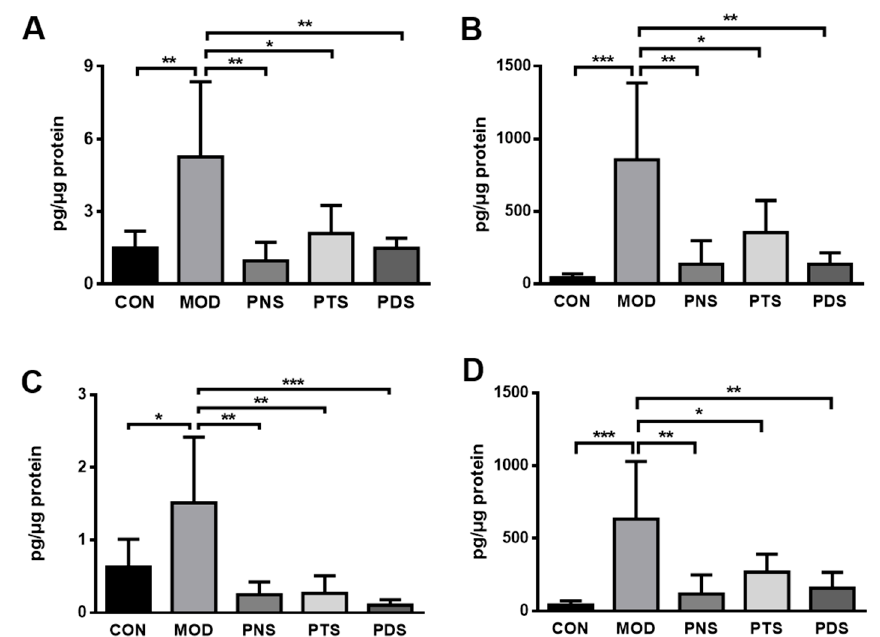
Figure 6. The productions of TNF- α ( A ), IL-6 ( B ), IL-1 β ( C ), and MCP-1 ( D ) in the ex vivo culture medium of the aortic arch. Data were presented as mean ± SD (n = 6). *, p < 0.05; **, p < 0.01; ***, p < 0.001.